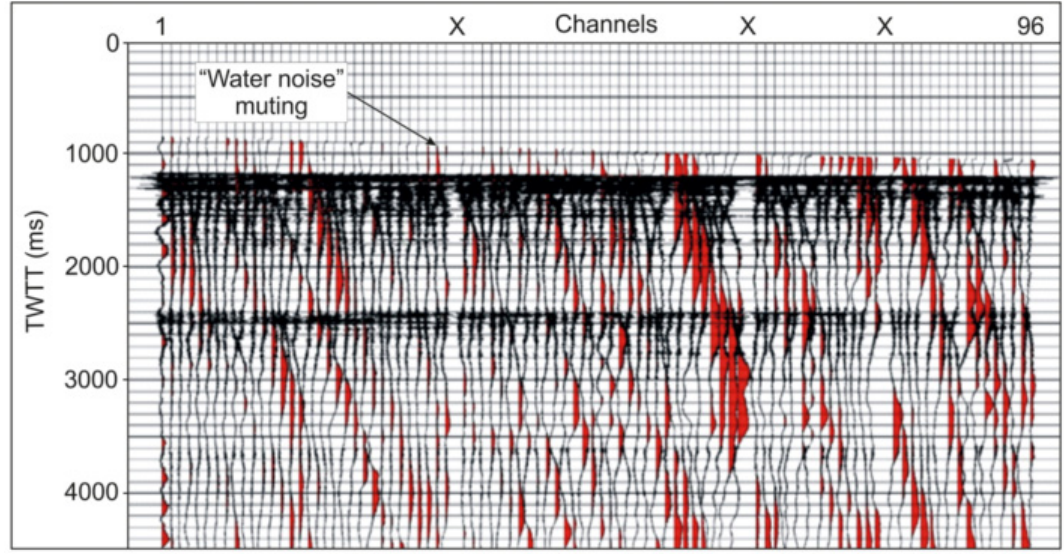
Figure 6. Water noise and noisy trace muting. In this example a raw records of the L_I02_HR is displayed with the water-column noise and the 33th, 65th and 80th traces muted